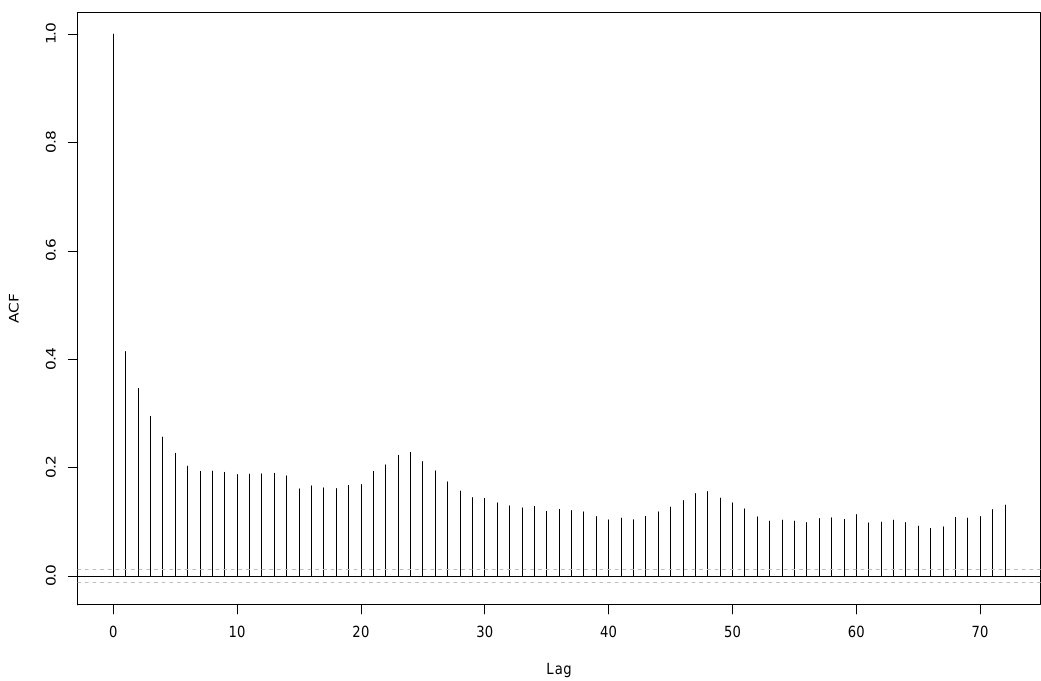
Figure 6. Autocorrelations of the dispersion measure VSD final , the volume-weighted average standard deviation for the final trading hour. Especially for small lags, the correlation is pronounced. A correlation with the price fluctuations of the same hourly contract on the previous day (lag 24) can also be